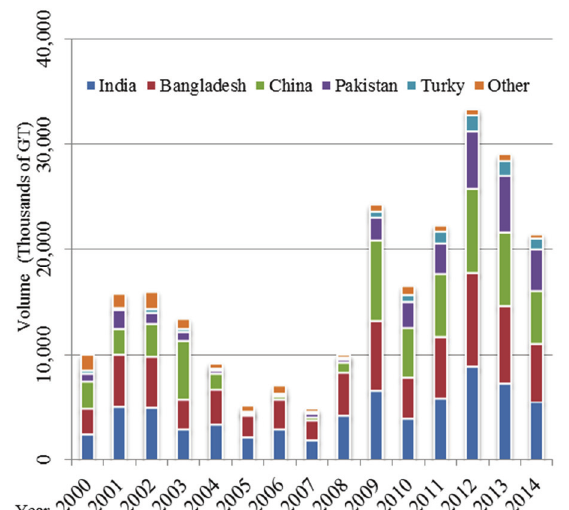
Figure 1. Ship recycling volume of major countries in the international market between year 2000 and 2014, (source of World Casualty Statistics © IHS Global